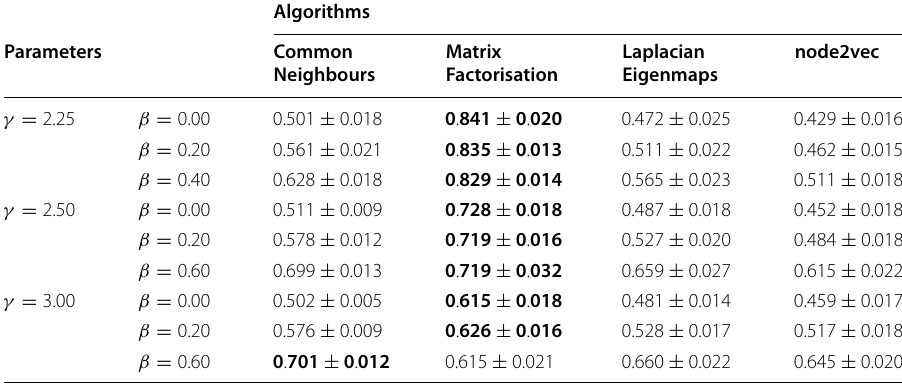
In each class of networks, the AUC of the algorithm that performs the best is in bold